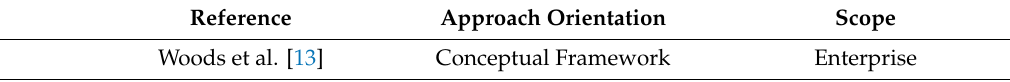
Table 1. Analysis of approaches related to enterprise resilience